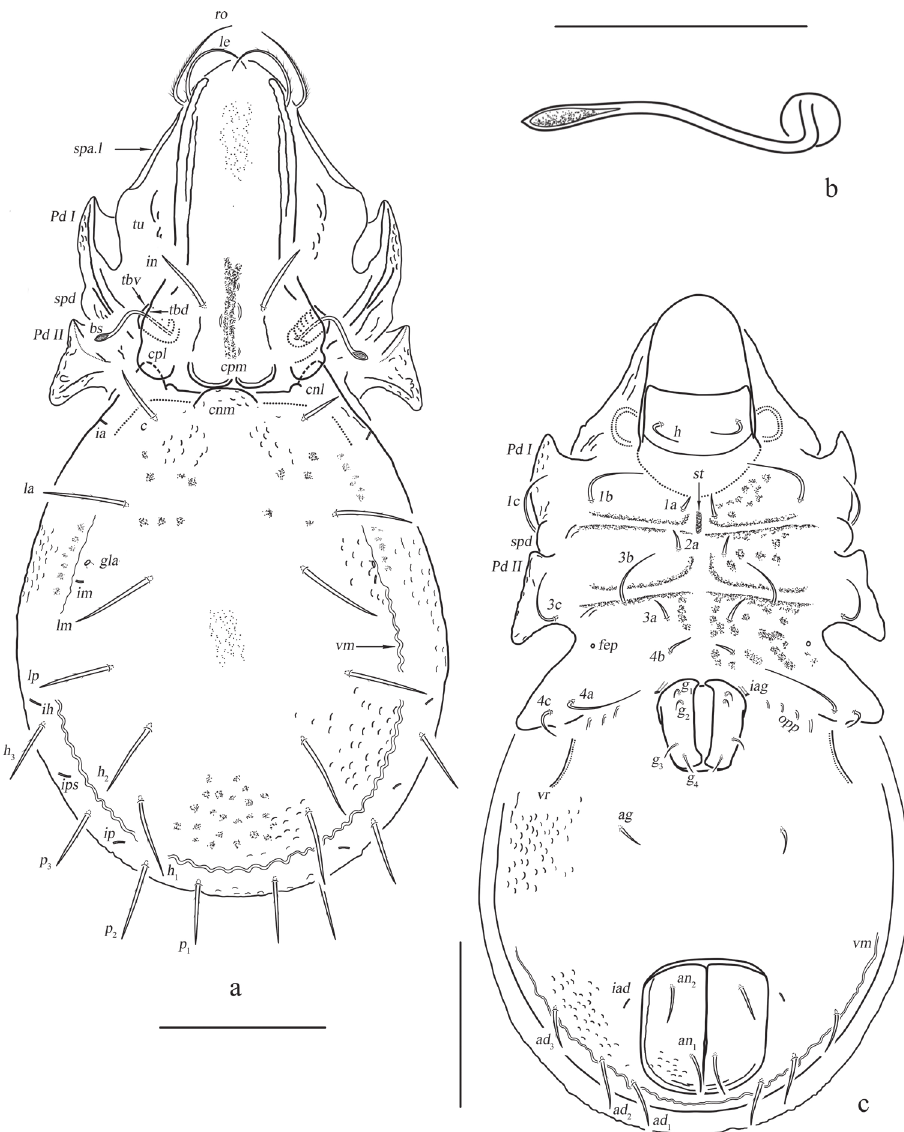
Figure 1. Basiceramerus ovatus sp. nov. adult: a dorsal view (legs not illustrated) b bothridial seta c ven- tral view (legs not illustrated). Abbreviations and notations explained in text. Scale bars: 200 μm ( a, c ); 100 μm ( b ). Integument . Body color light brownish. Surface of notogaster foveolate. Prodorsum . Rostrum rounded. Rostral setae moderately curved inward, densely barbed outside. Lamellar setae inserted behind tip of lamella, curved inward, rough- ened outside. Interlamellar setae barbed and setiform, a pair of longitudinal